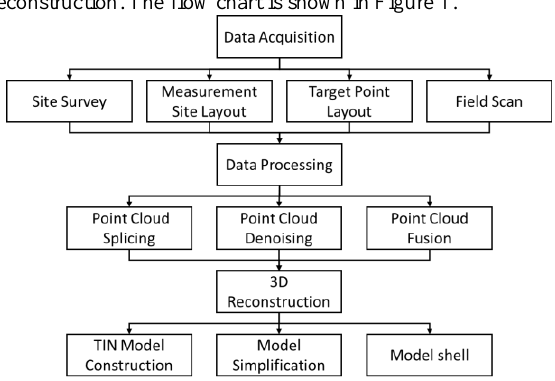
Figure 1. The process of point cloud acquisition and three- dimensional reconstruction